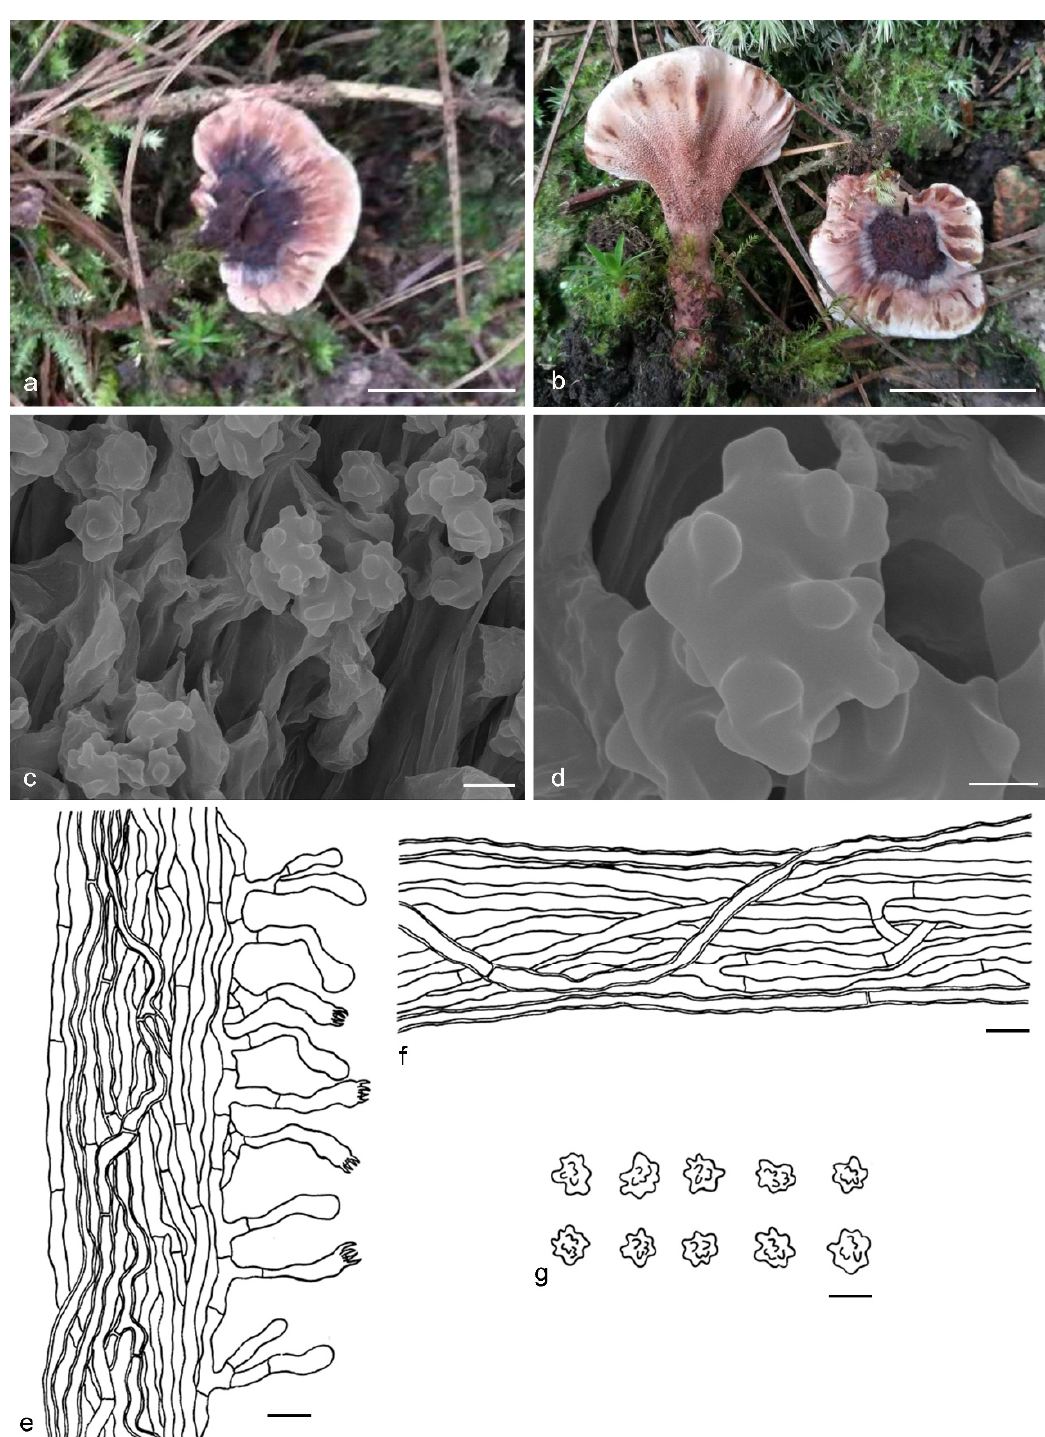
Figure 13. Hydnellum yunnanense. ( a , b ): Basidiocarps; ( c , d ): SEM of basidiospores; ( e – g ): Microscopic structures (drawn from IFP 019429); ( e ): Section of hymenophore trama with basidia; ( f ): Hyphae from pileus context; ( g ): Basidiospores. Scale bars: ( a , b ) = 1 cm; ( c ) = 3 μm; ( d ) = 1 μm; ( e , f ) = 10 μm; g = 5 μm. Hydnellum sp 3 Basidiocarps annual, solitary. Pileus applanate, flabelliform. Pileal surface brown (7E7) to dark brown (7F7), concentrically zonate and pubescent. Spines reddish brown (9E6) and